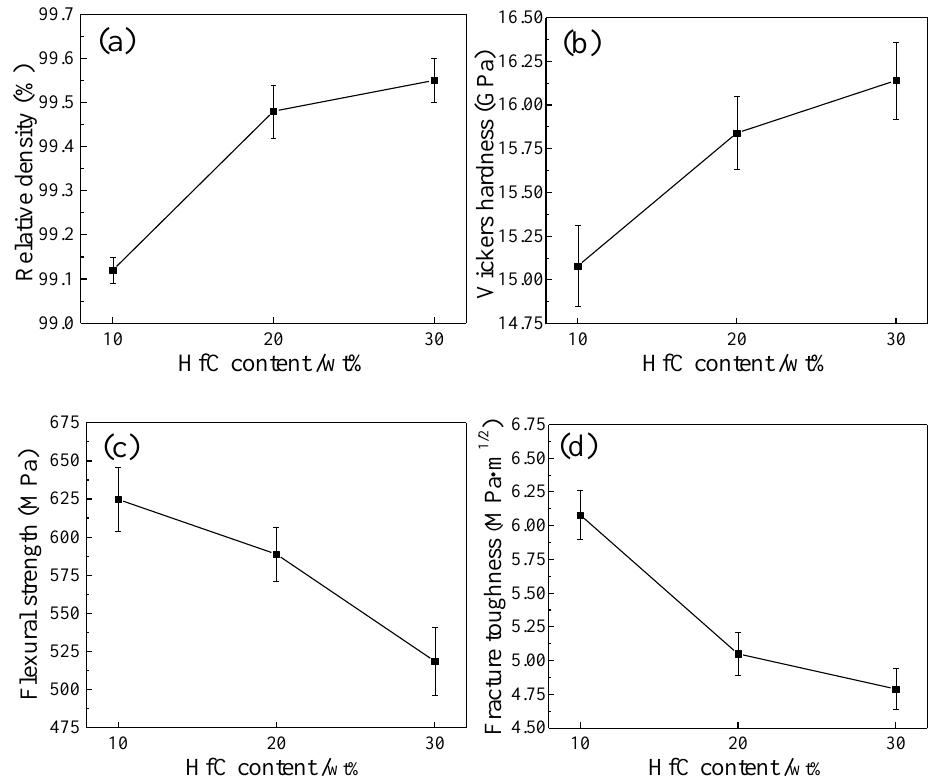
Figure 5. Relative density and mechanical properties of ZrB 2 –HfC ceramics with different HfC content: ( a ) Relative density, ( b ) Vickers hardness, ( c ) Flexural strength, and ( d ) Fracture toughness.